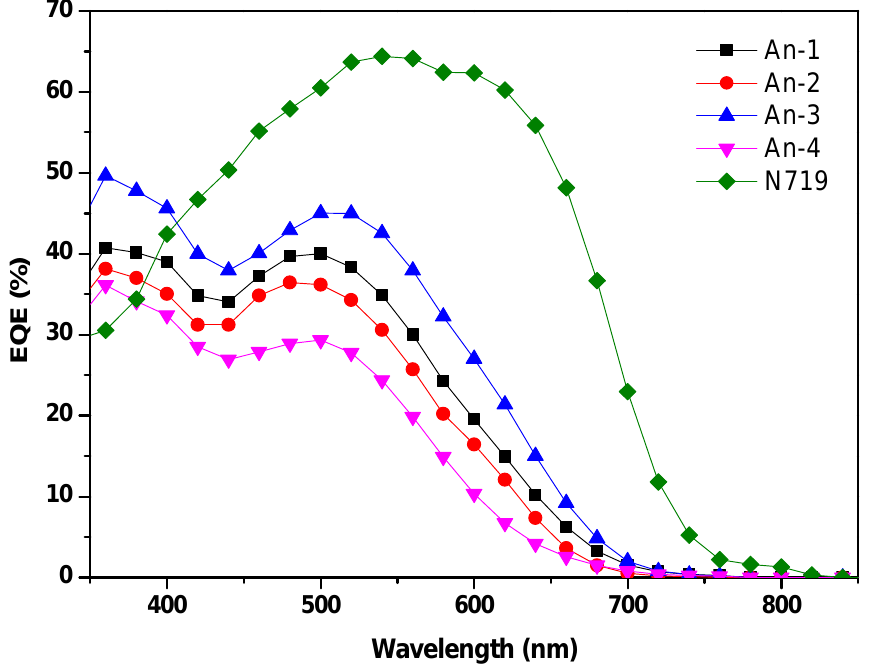
Figure 6. Incident monochromatic photo-to-current conversion efficiency (IPCE) plots for the DSSCs